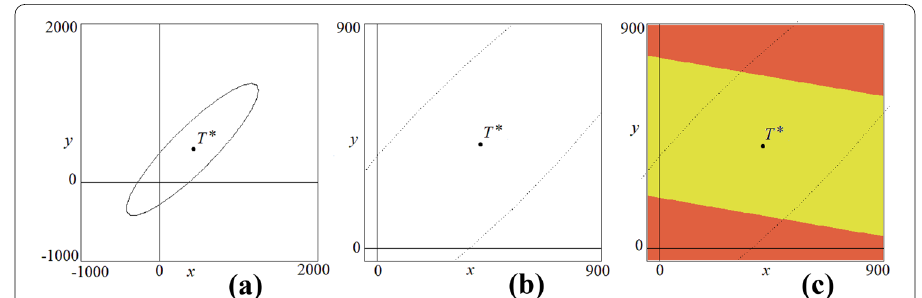
( T k , T k 1 ) for b = 1.5 , = +